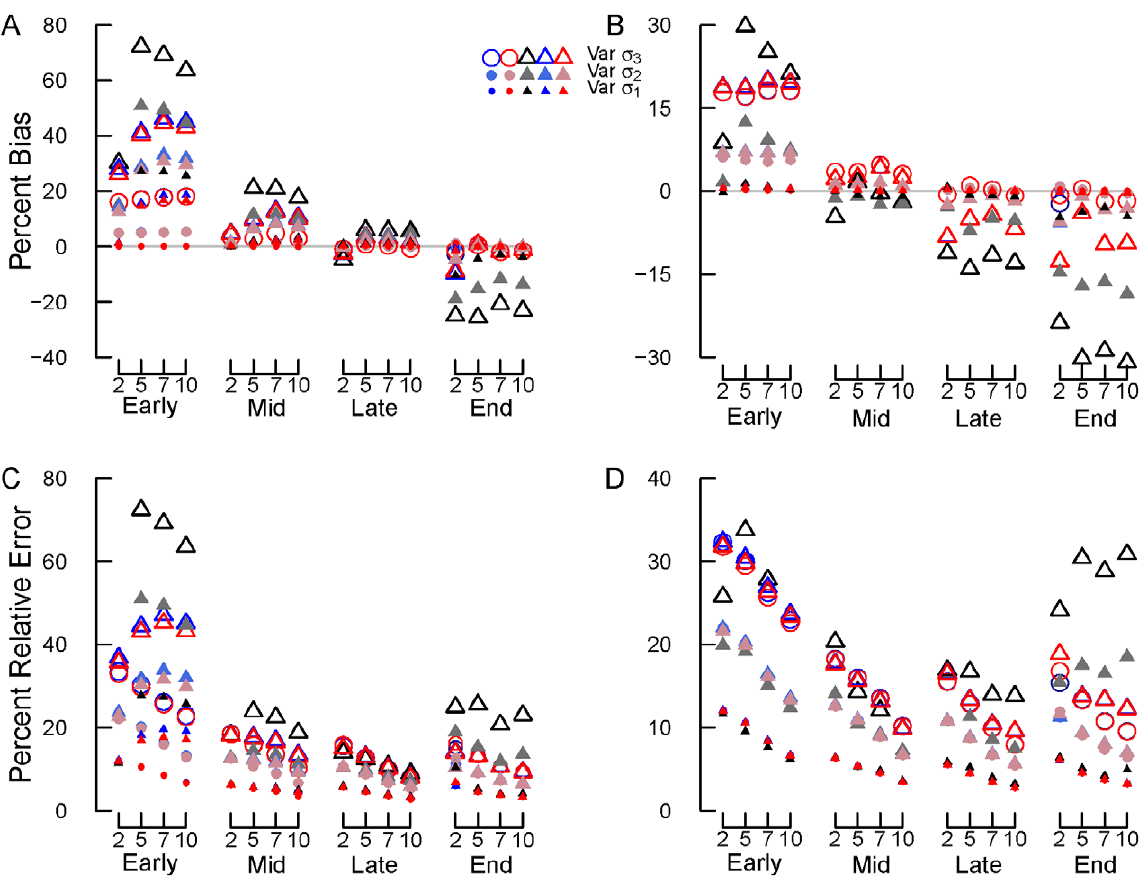
Figure 7. Results for simulations with variable normal errors (option 1). Percent bias using (A) SV and (B) REP transformations and relative error using (C) SV and (D) REP transformations. Early, mid, late and end are early, mid, late and end stage decomposition simulations. The numbers 2, 5, 7 and 10 are the numbers of measurements used in each simulation. Blue circles=NLS, Red circles=Normal ML, gray/black circles=Beta ML. In most cases, nls=Normal ML so that the red circles cover the blue circles. Gray lines in panels (A) and (B) show 0% bias.